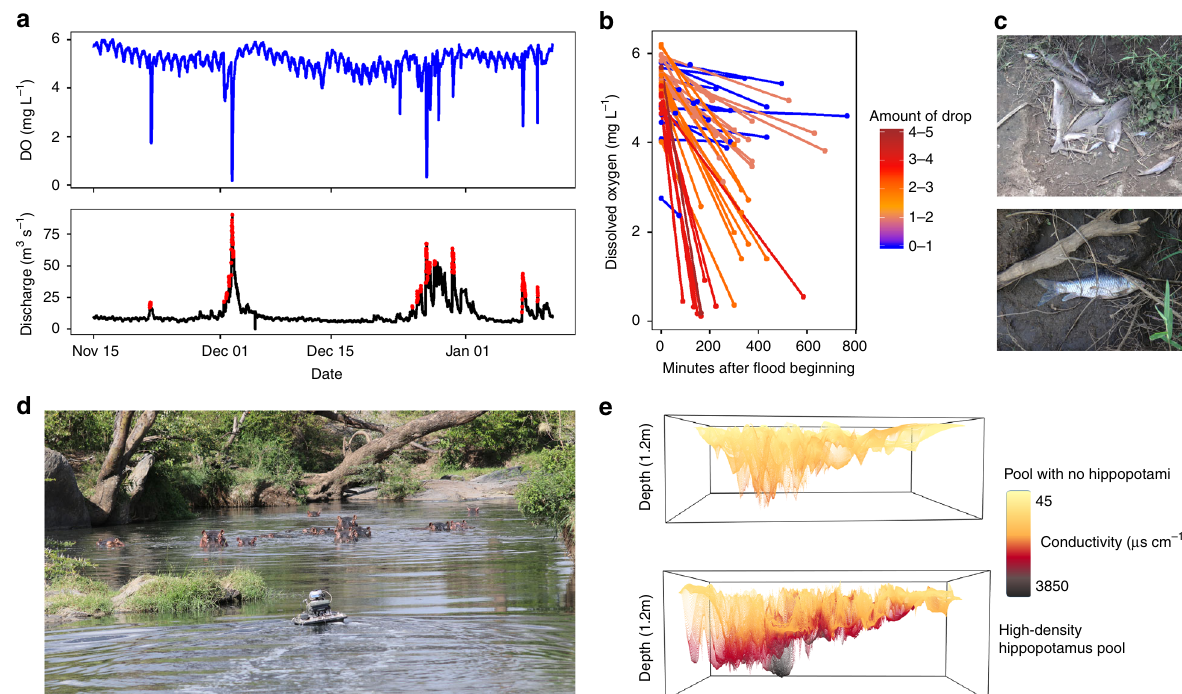
Fig. 1 Observations of fl ushing fl ows, hypoxic events, fi sh kills, and hippo pools in the Mara River. a Dissolved oxygen (blue) and discharge (black) for a 3- month subset of data from November 2014 through January 2015. Red indicates discharge >2 times the calculated base fl ow. b Dissolved oxygen at the beginning and lowest value for each fl ushing fl ow from the 3-year record. c Dead fi sh from a fi sh kill observed on December 10, 2013 (image credit: Christopher Dutton). d Robotic boat surveying a hippo pool (image credit: Amanda Subalusky). e 3-D interpolation of the conductivity within pools lacking or containing high densities of